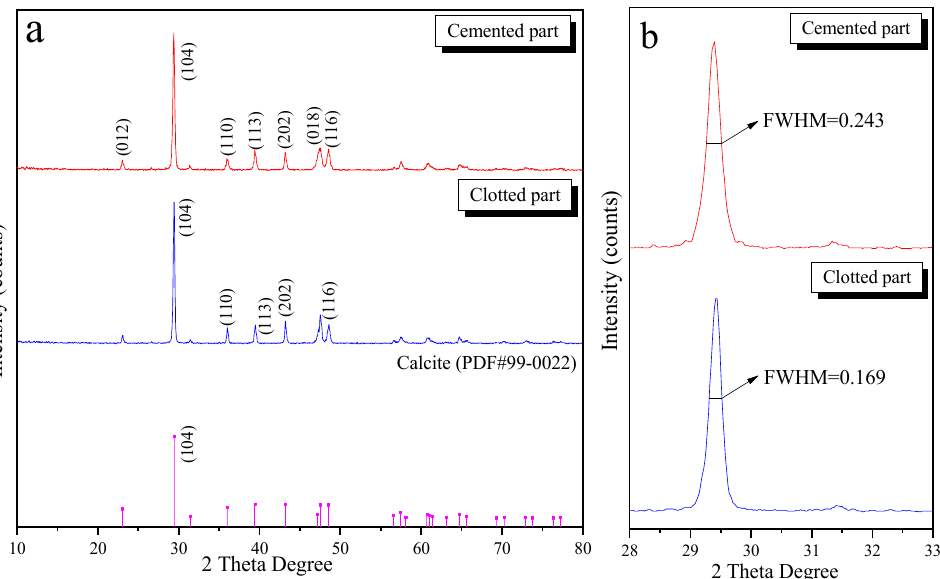
Figure 2. XRD analysis of cemented and clotted parts in thrombolite. ( a ) the mineralogical compositions of the cemented and clotted parts; ( b ) the Full Width at Half Maximum (FWHM) of cemented and clotted parts.